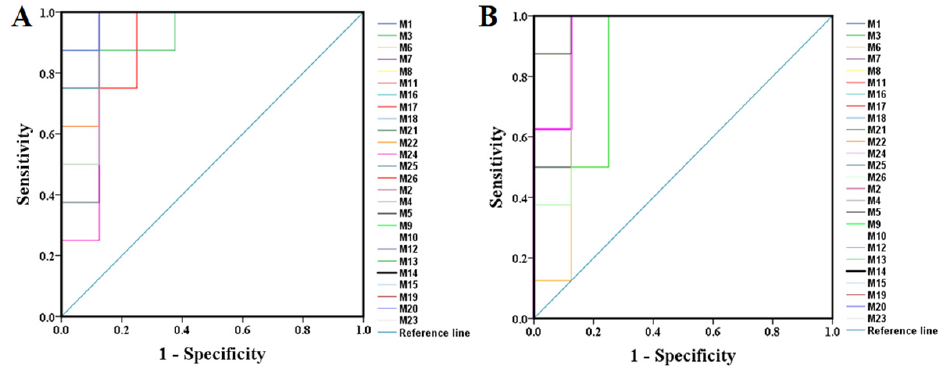
Figure 6. The predictive ROC curves generated using 26 biomarkers contributing to GU progress ( A ) and PPT treatment ( B ) (the numbers are consistent with No. in Table 1). Table 2. The AUCs and p values of the biomarkers in different predictive ROC curves.